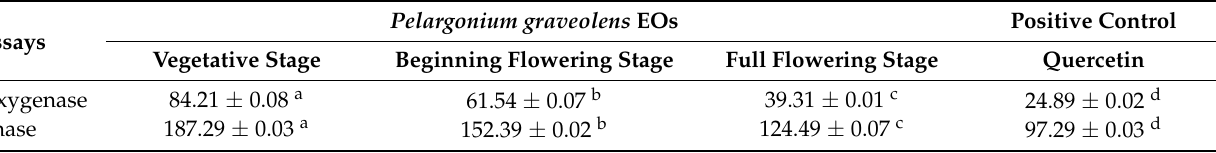
Table 6. In vitro anti-inflammatory and dermatoprotective activities of PGEOs at three phenological